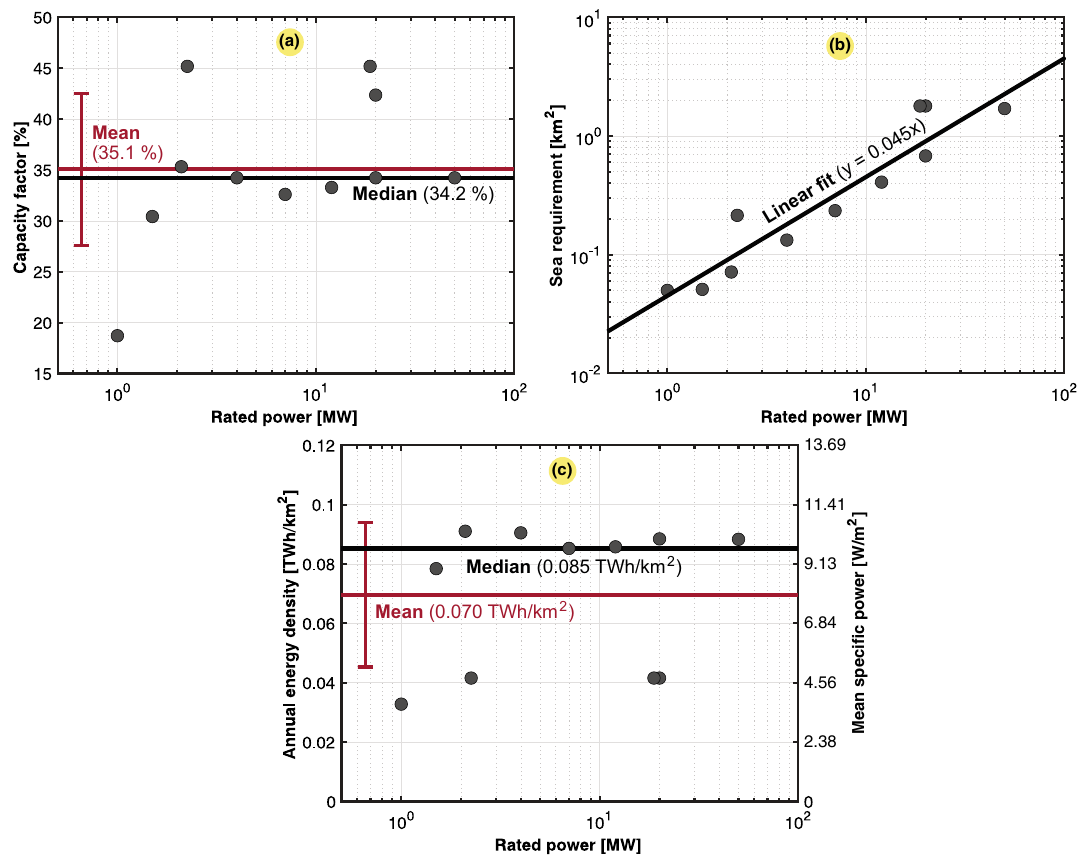
Figure 13. Case study of 11 prototype or designed wave power plants worldwide ( n = 11 ), 1 in Scotland, 2 in Portugal, 2 involving Wave hub, 4 involving Wave dragon, 1 involving AWS, and 1 involving the Wave dragon wave generator. Typical, mean, median, and fitted values are also included. ( a ) Capacity factor ( C g ). ( b ) Land